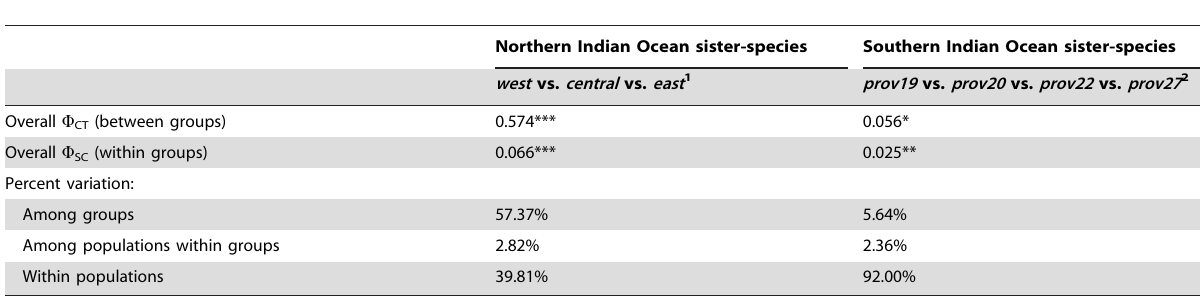
Table 2. AMOVA results for the Southern and Northern Indian Ocean